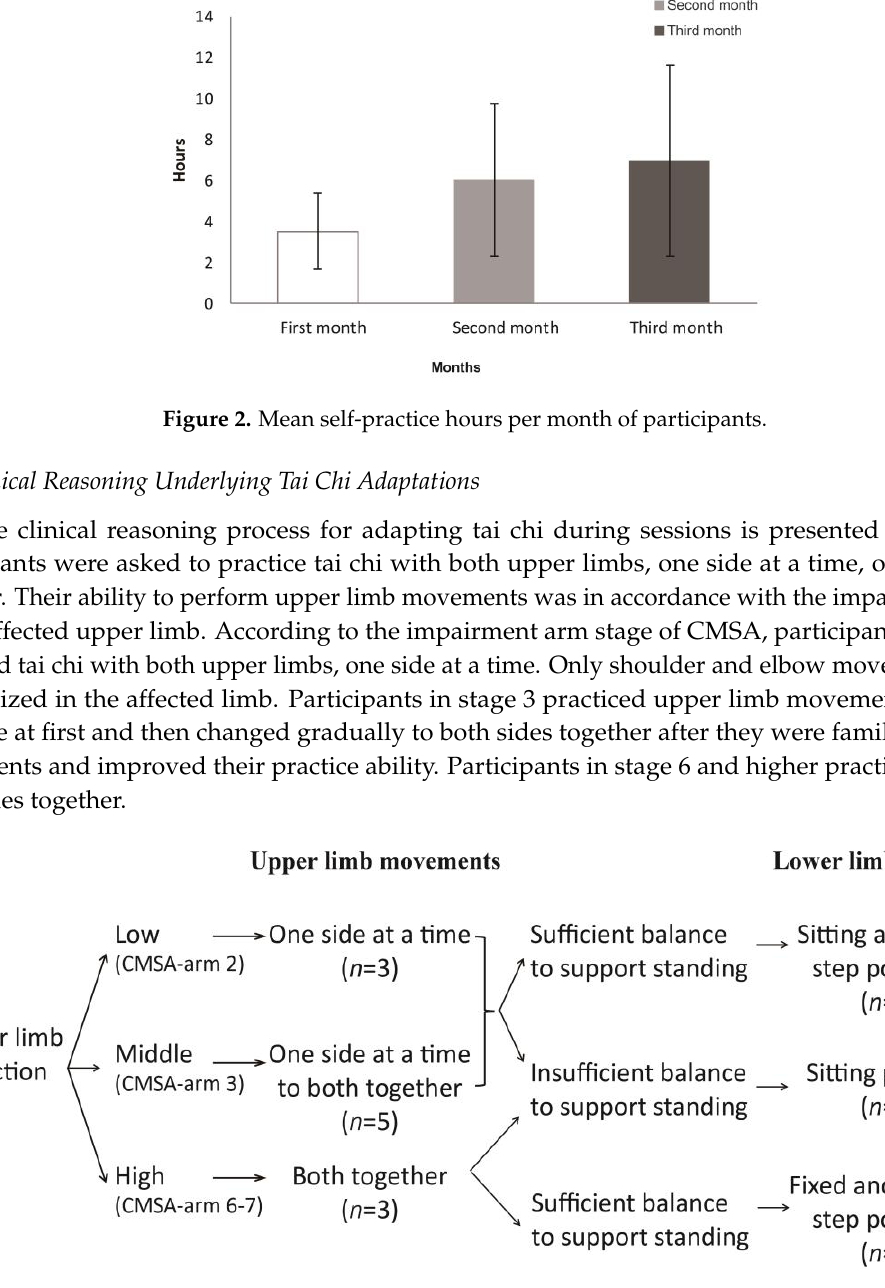
Figure 3. Clinical reasoning for adapting tai chi in the study, including upper limb movements and lower limb positions used by participants. CMSA-arm: arm stage of Chedoke–McMaster Stroke Assessment. Three lower limb positions were employed based on balance level, including sitting, fixed step,